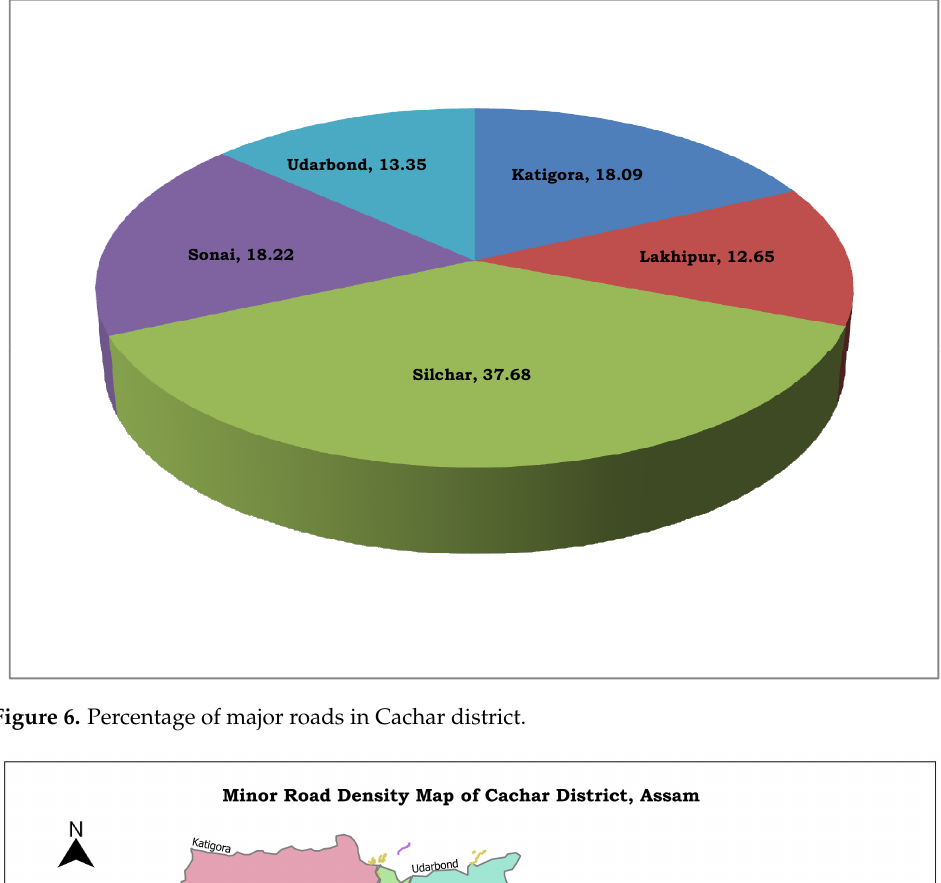
Figure 6. Percentage of major roads in Cachar district.